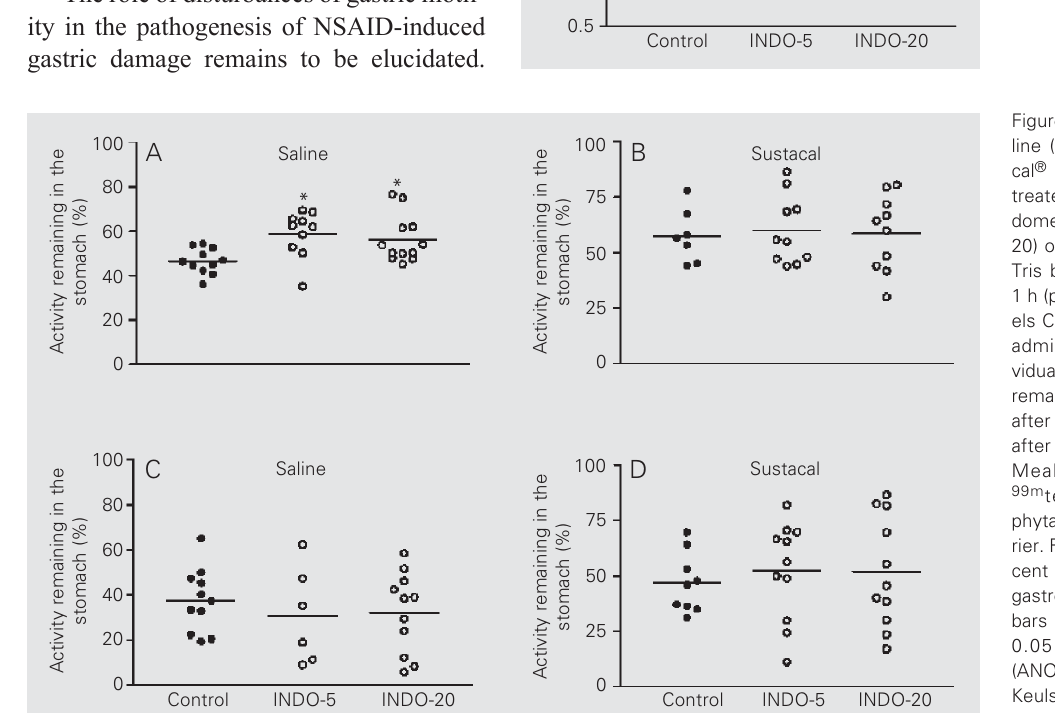
Figure 3. Gastric tone (volumes measured under a fixed intra- gastric pressure) in rats treated with 5 or 20 mg/kg indometha- cin (INDO-5 or INDO-20) or con- trol rats injected with Tris buf- fer. Measurements were started 1 h (panel A) or 3 h (panel B) after indomethacin administra- tion. Data are individual values of gastric volume (in ml) re- corded by plethysmography in anesthetized rats. The individual values were pooled into 10-min intervals. The horizontal bars represent the means. *P < 0.01 compared to control (ANOVA followed by Newman-Keuls test).